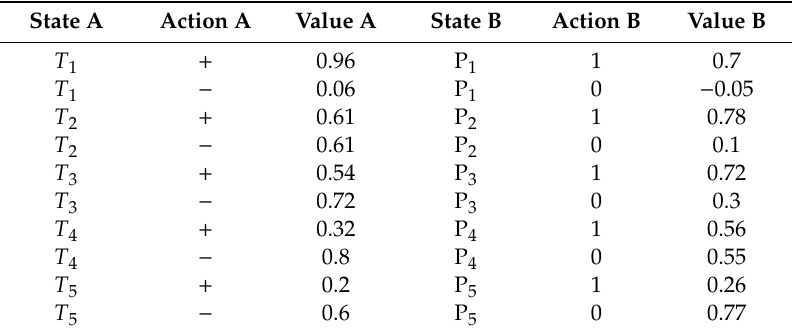
Table 14. Q Function table of the first iteration.